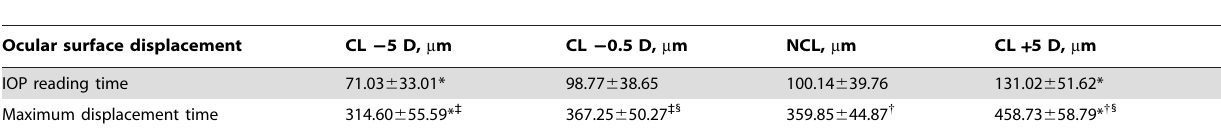
Table 3. Comparison of ocular surface displacement at 14.8 ms, the IOP reading time and the maximum displacement time.